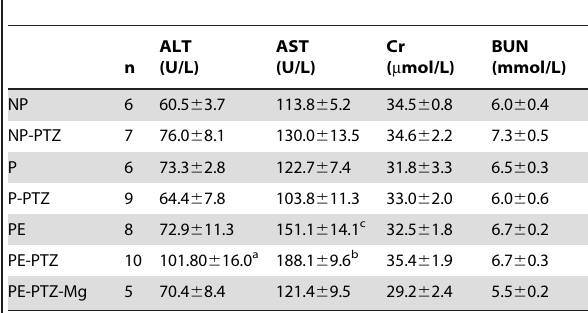
Table 1. Biochemical indices of different groups on GD